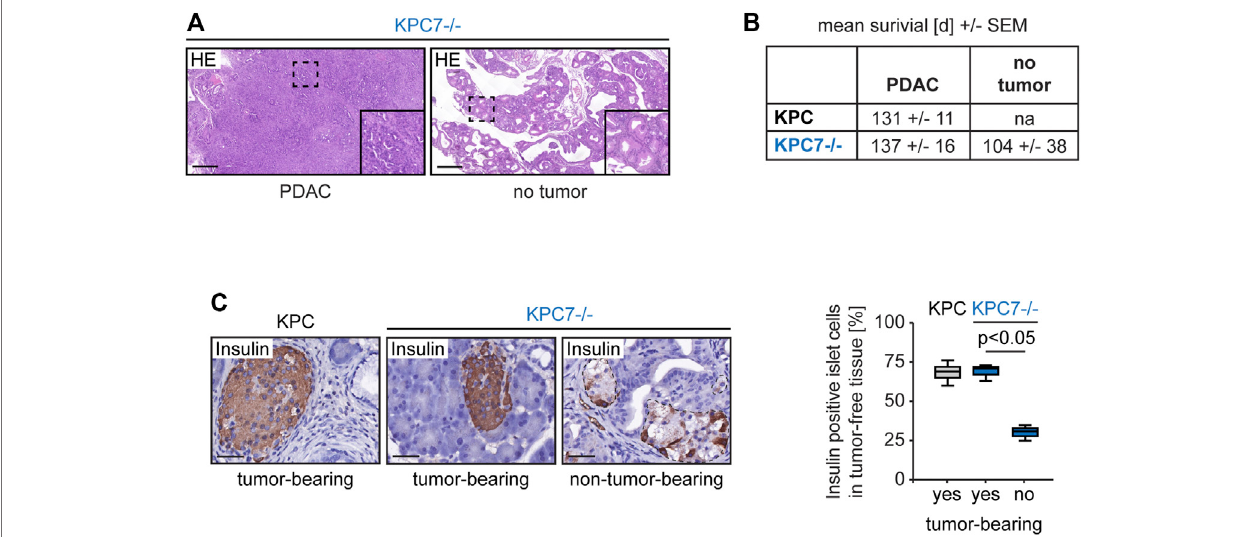
FIGURE2| Alteredpancreasmorphologyandreducedpercentage ofinsulinexpressingcellsinnon-tumor-bearingKPC7 − / − mice. (A) Representativehistologyas indicated.Scalebars represent 1,000 µm. (B) Survivaltimesasindicated. (C) Representativeimmunohistochemistry forInsulin inisletsofLangerhansandquanti fi cation as indicated. Scale bars represent 40 µm. Statistics: Welch ’ s t -test (n from left to right: 6/3/3).